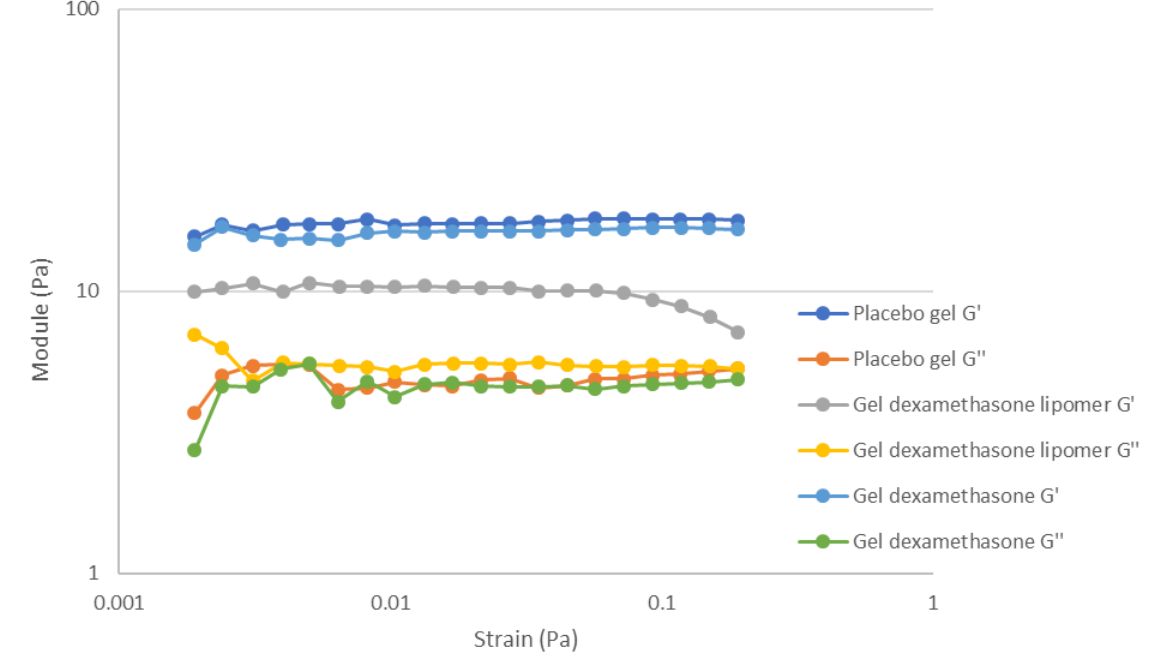
Figure 6. Storage and loss modulus of the hydrogel formulations. Table 7. Viscoelasticity parameters of hydrogel placebo, dexamethasone hydrogel, and freeze-dried dexamethasone lipomers hydrogel (mean ± standard deviation (SD)). (*) denoted statistical differences p < 0.05.